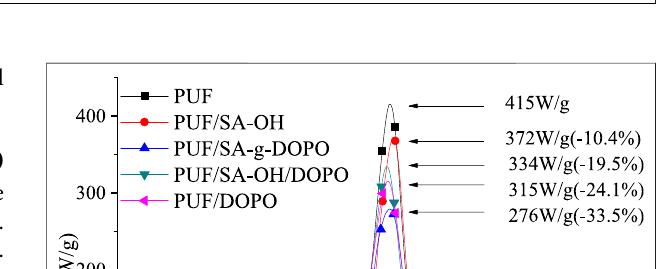
FIGURE 7 | Picture of SA-OH and SA-g-DOPO in the water.